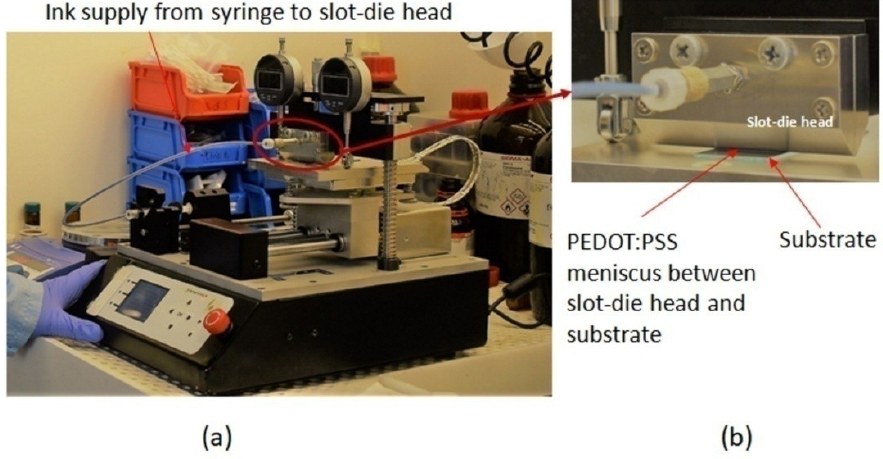
Figure 1. ( a ) Picture of the slot-die coater, which was placed in the fume-hood. ( b ) Image of the PEDOT:PSS meniscus formed between slot-die head and glass substrate.